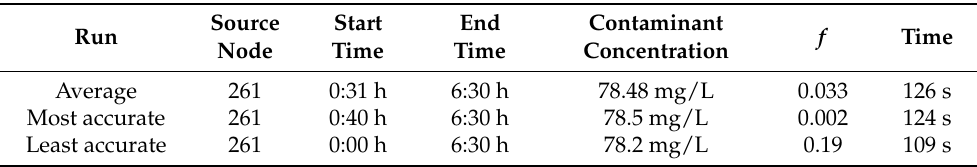
Table 9. Framework 2 results for the NET3